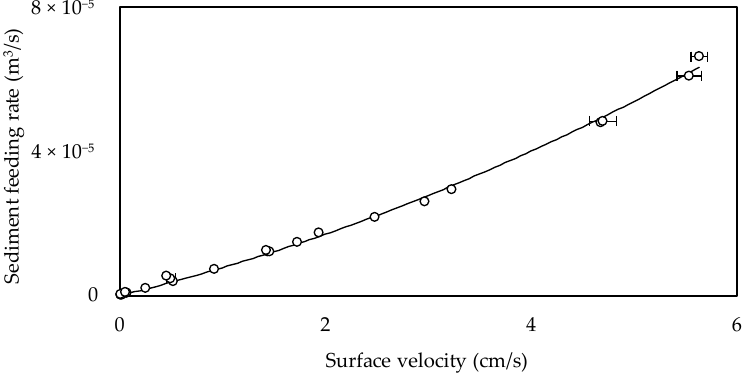
Figure 9. Relationship between the time-mean values of the sediment surface sediment velocity and feeding rate. Uncertainty bars for sediment velocity are displayed only if larger than the marker size (threshold value for display = 0.04 cm/s). Uncertainty bars for sediment feeding rate are never visible.